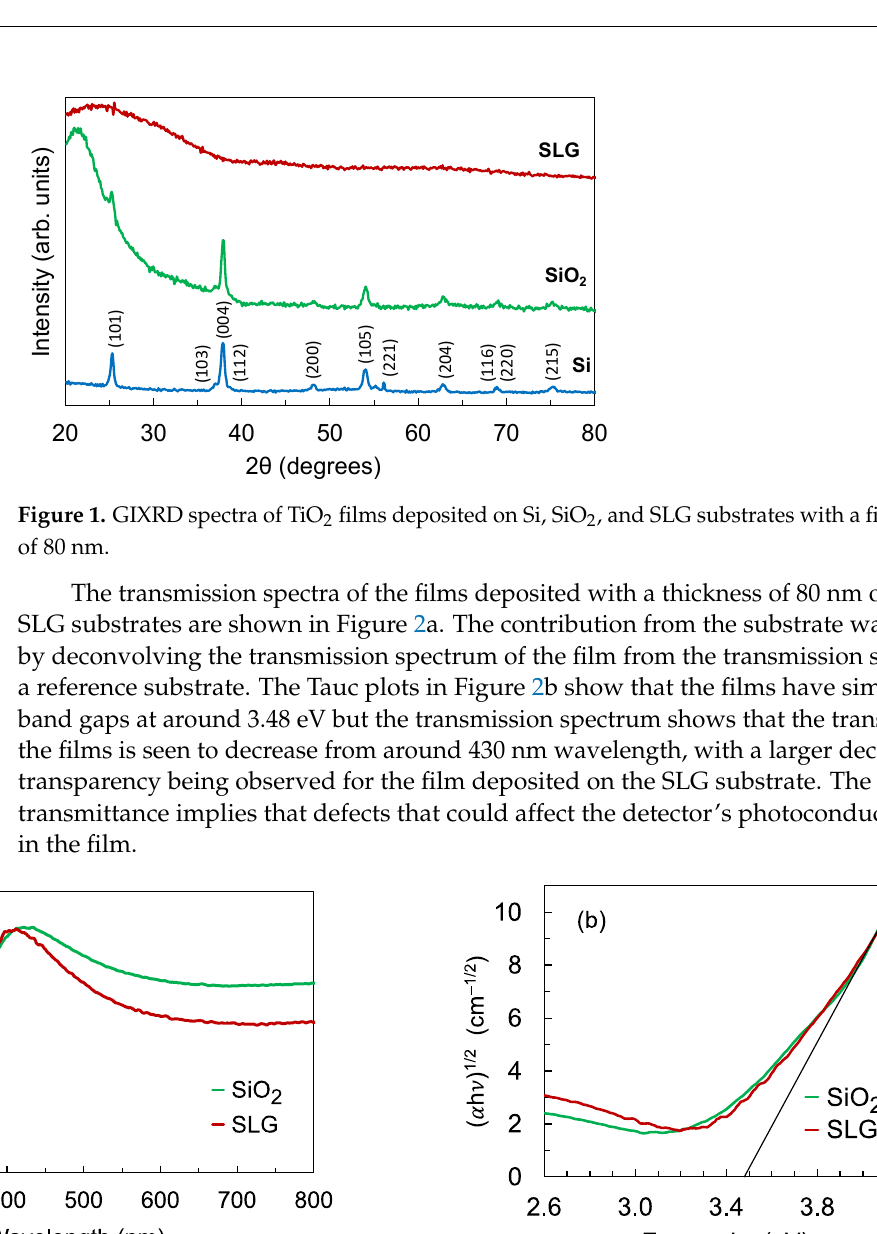
Figure 2. ( a ) Transmission spectra of the films deposited with a thickness of 80 nm on SiO 2 and SLG substrates; ( b ) Tauc plots showing a similar optical band gap energy of 3.48 eV for the films depos- ited on both SiO 2 and SLG substrates. The optical band gap was estimated from the x-intercept of the linear region.